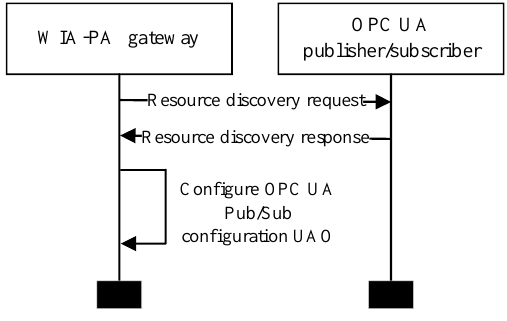
Figure 8. Resource discovery process.